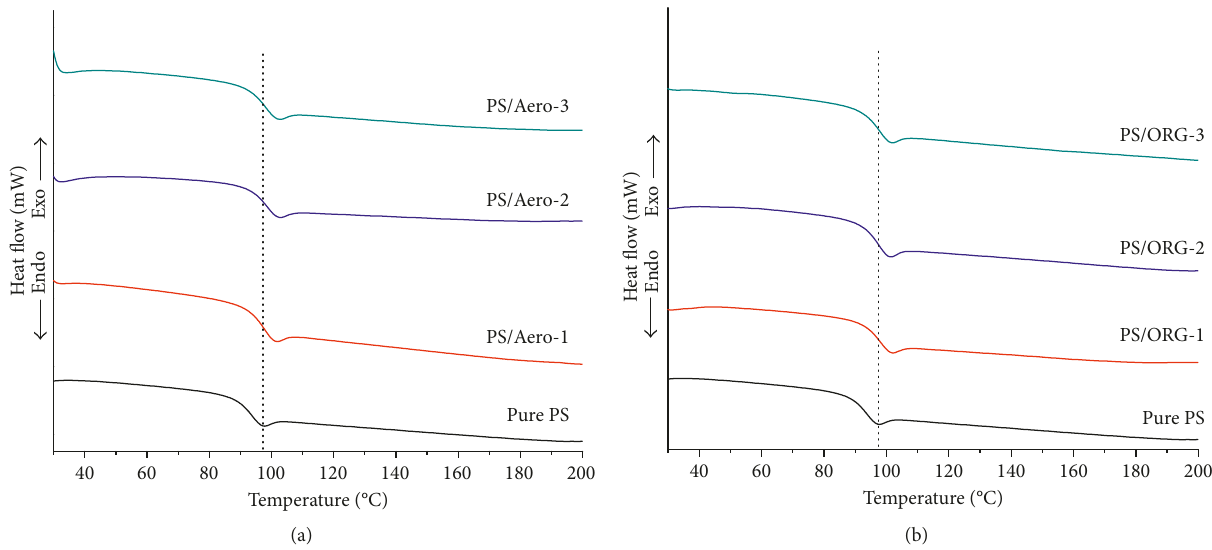
Figure 10: DSC thermograms of PS/clay nanocomposites prepared from the nanoclay aerogel masterbatch and organoclay. Table 6: DSC and TGA results of PS/clay nanocomposites pre- pared from the nanoclay aerogel masterbatch and organoclay.